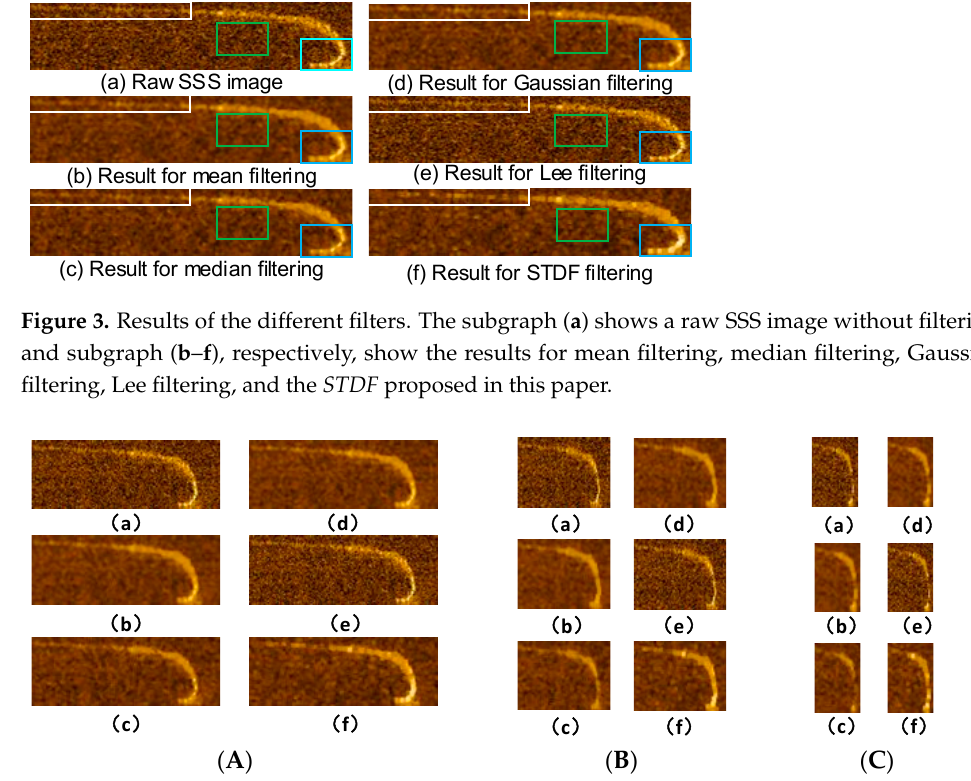
Figure 4. Results of different filters for downsampled sonar images. The column downsampling factors for subgraph ( A ), subgraph ( B ), and subgraph ( C ) are 2, 4, and 8, respectively. ( a ) Raw SSS image. ( b ) Results for mean filtering. ( c ) Results for median filtering. ( d ) Results for Gaussian filtering ( e ) Results for Lee filtering. ( f ) Results for proposed STDF .